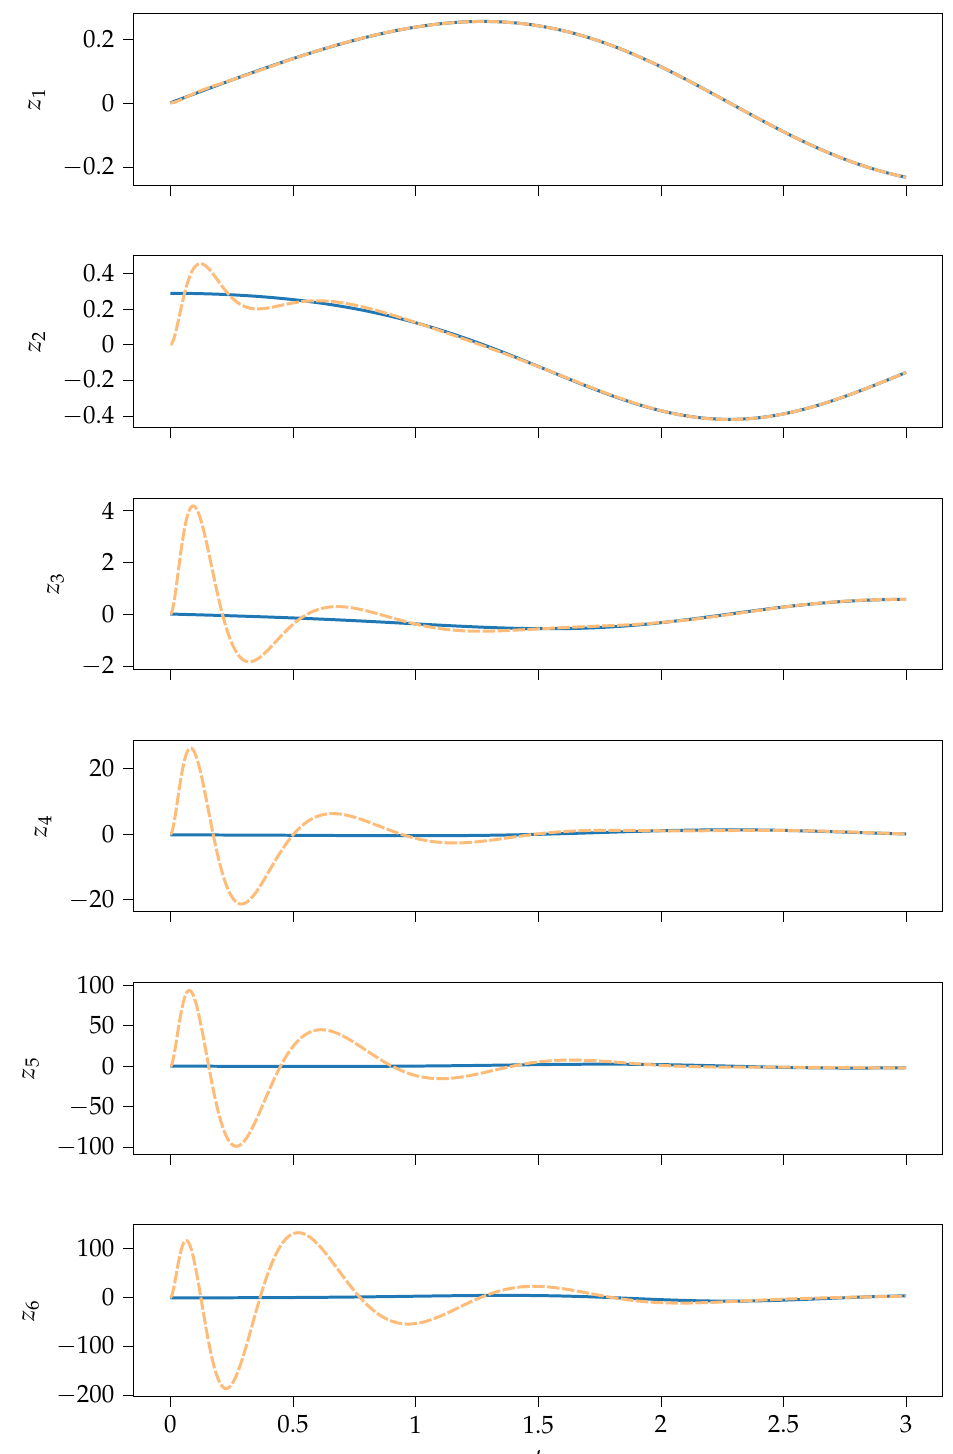
Figure 2. Trajectories for the embedded system state z (blue/dark/solid) and the observer state ˆ z (orange/lightdashed) of the Duffing oscillator